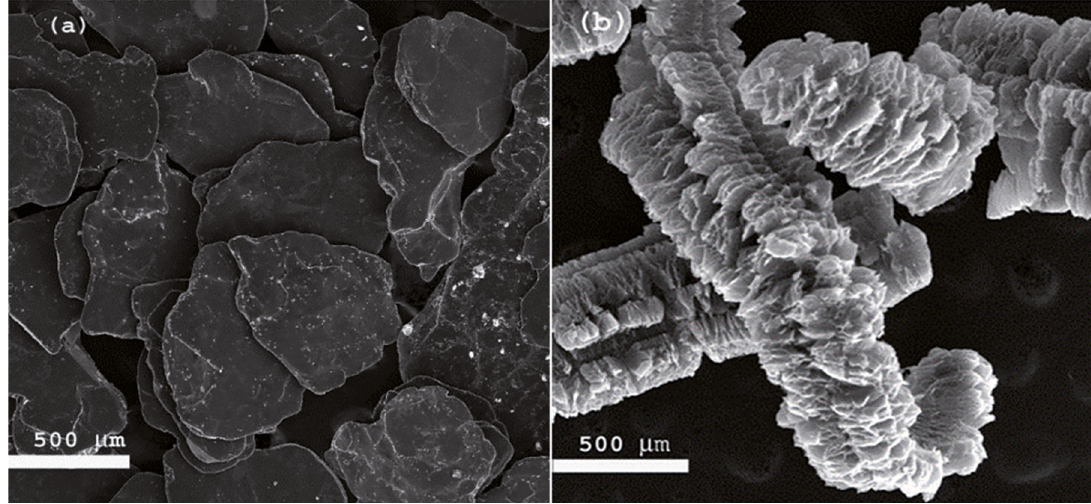
Figure 1: SEM micrographs of a) Expandable, b) Expanded graphite